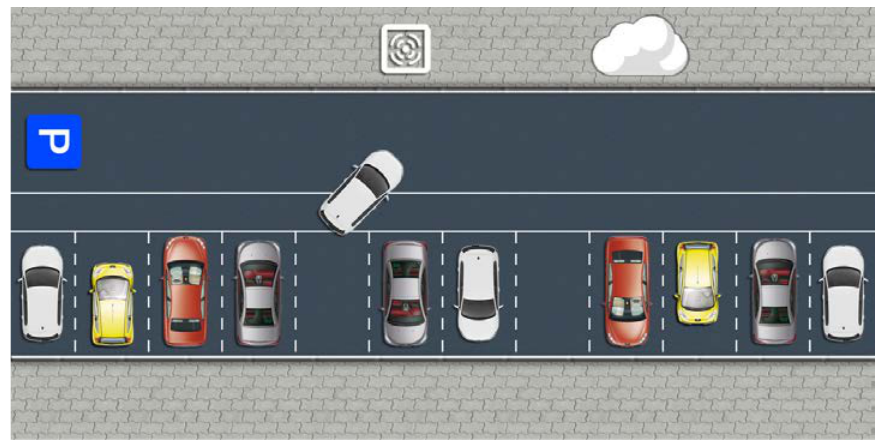
Figure 5. Remote driving for automated parking use case.